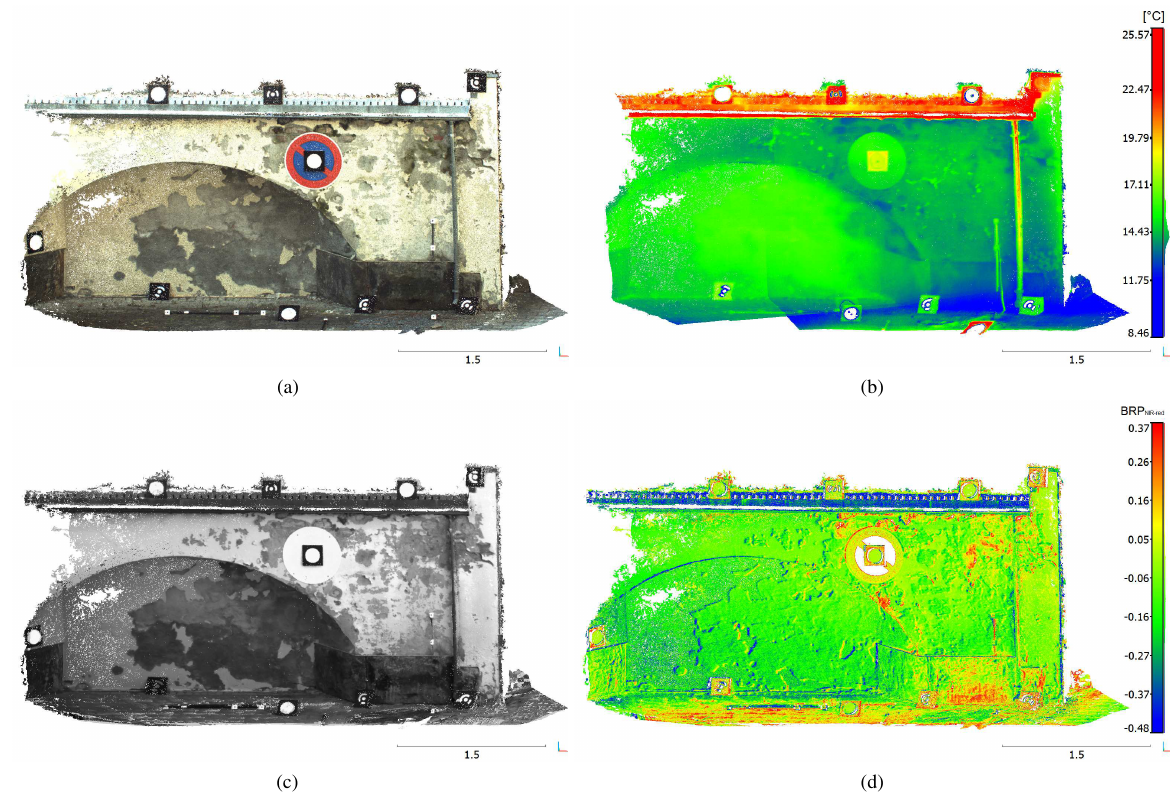
Figure 8: Multiattributed point cloud with: (a) RGB, (b) thermal, (c) near infrared and (d) band ratio parameter ( BPR NIR − red )